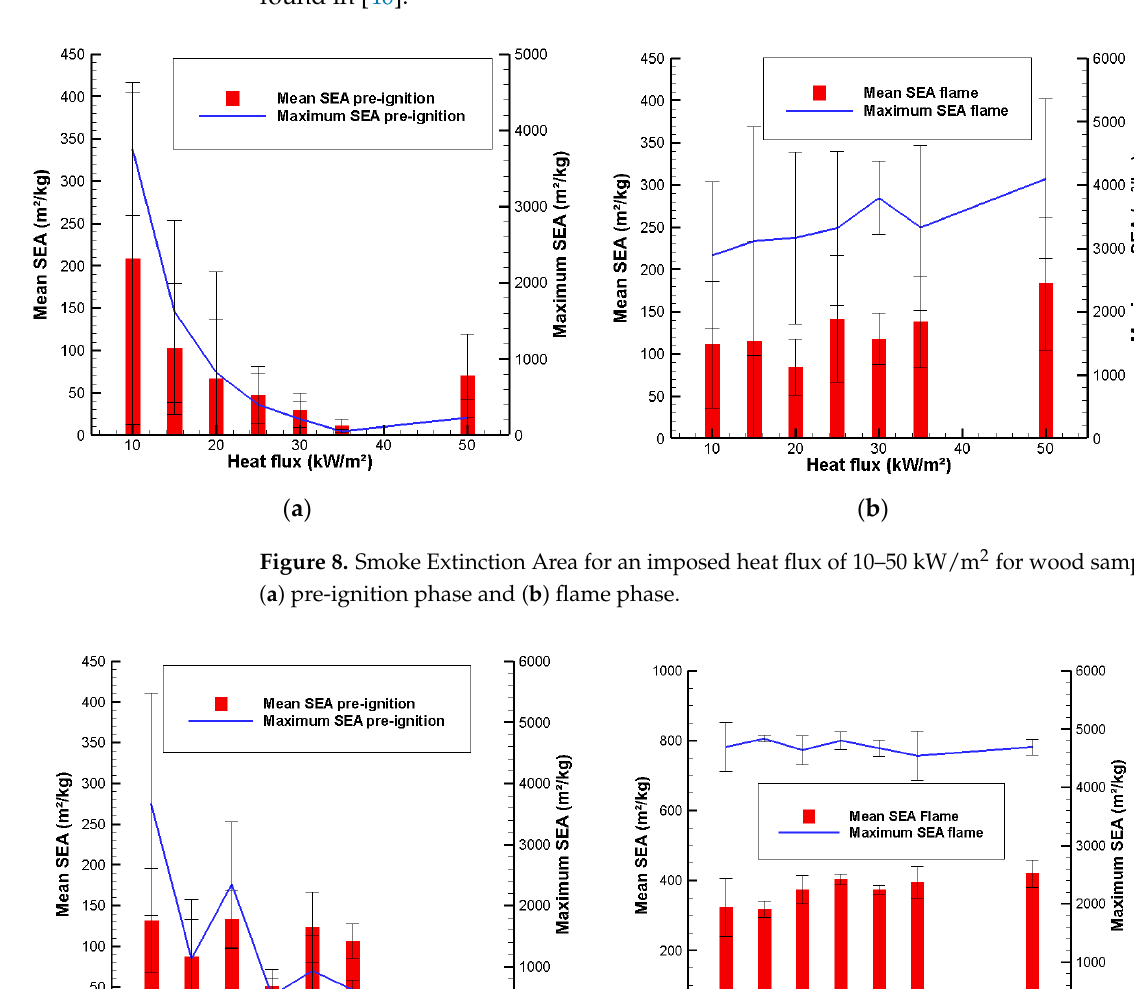
( b ) Figure 7. Smoke Production Rate (SPR) as a function of time for di ff erent imposed heat fl uxes for ( a ) wood and ( b ) thermoplastic samples. 3.2.3. Smoke Extinction Area The speci fi c extinction area, SEA, which is the ratio of the smoke production rate to the mass loss rate, is used here to compare the smoke production per unit burning mass for each phase, pre-ignition and fl ame. The mean and maximum SEAs for both phases are shown in Figure 8 for wood and Figure 9 for thermoplastic. For both materials, the maxi- mum and mean SEA values follow the same trend. In addition, the SEA results are con-